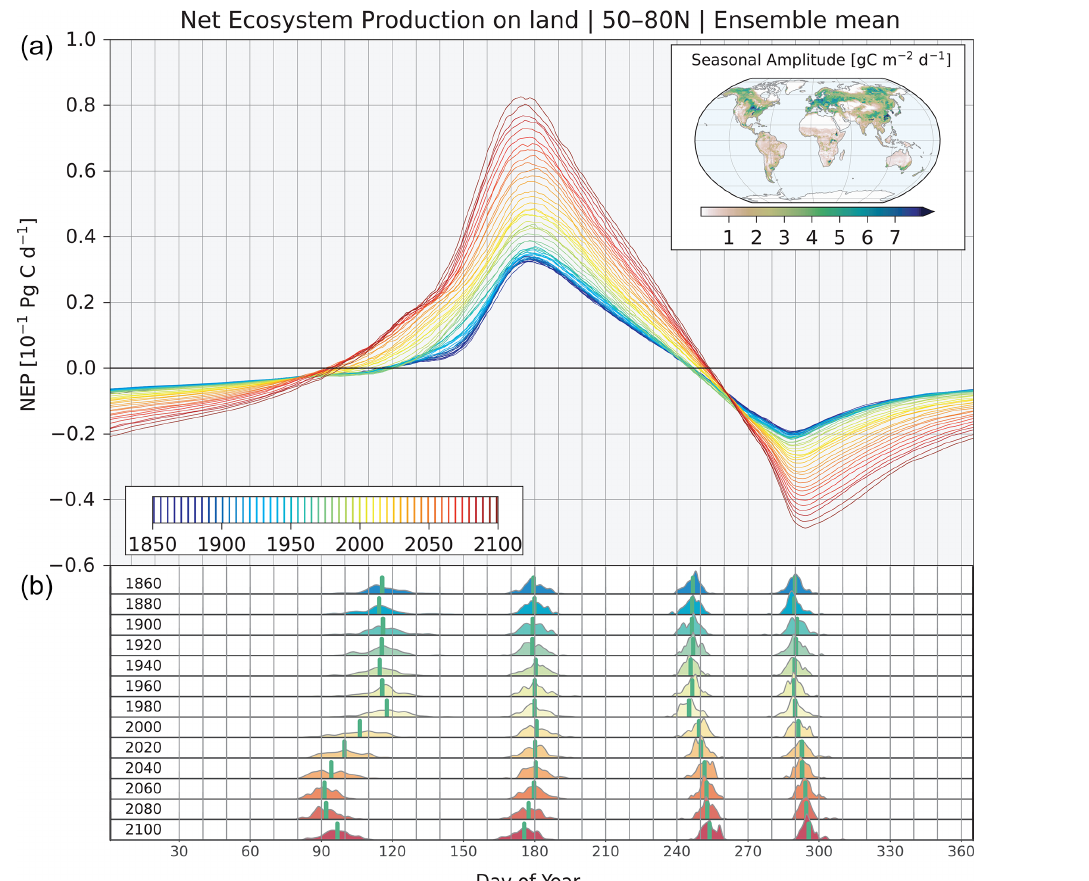
Figure 5. Expansion of growing season length, or equivalently the carbon uptake period, over 50 ◦ –80 ◦ N (shown here for all 90 members for which daily-mean land output was saved). (a) Evolution of ensemble-mean seasonal cycle (one line for every five years, color-coded) of integrated net ecosystem productivity (NEP), with positive values indicating net terrestrial carbon uptake and negative values indicating loss of carbon from the aggregated land region. The first zero crossing arks the start of the growing seasons, and the second zero crossing marks the end of the growing seasons. (b) Histograms of first occurrence of zero crossing, peak, second zero crossing, and minimum as a function of the day of the year. The horizonal axis for both panels is a climatological calendar day of the year, and aggregation is done across 90 members. The histograms represent model output sampled at 20-year intervals. The inlay map (upper right) shows the ensemble mean amplitude of the seasonal cycle of NEP averaged over 1960–1989 (gCm − 2 d − 1